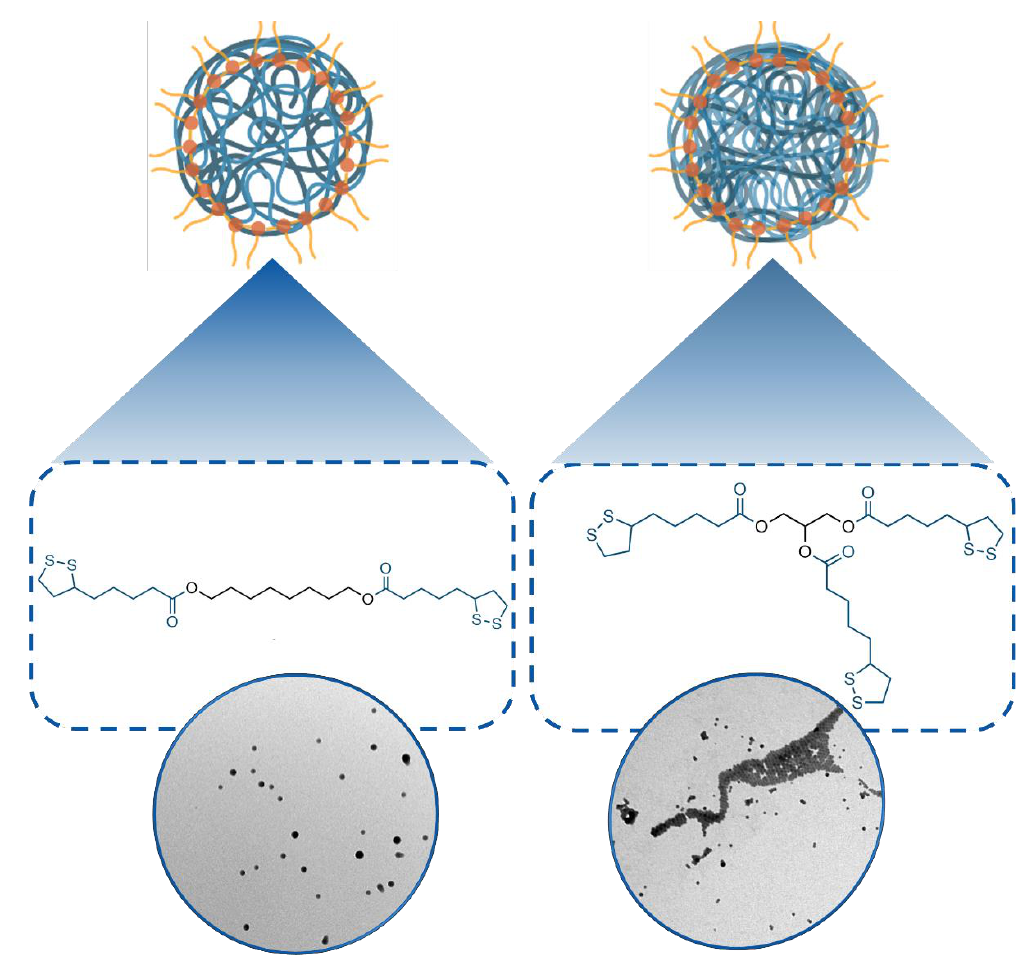
Figure 1. Chemical structure of the lipoic acid derivatives 1 and 2 studied in this work and their respective pluronic-stabilized poly(lipoic acid) nanoparticles.